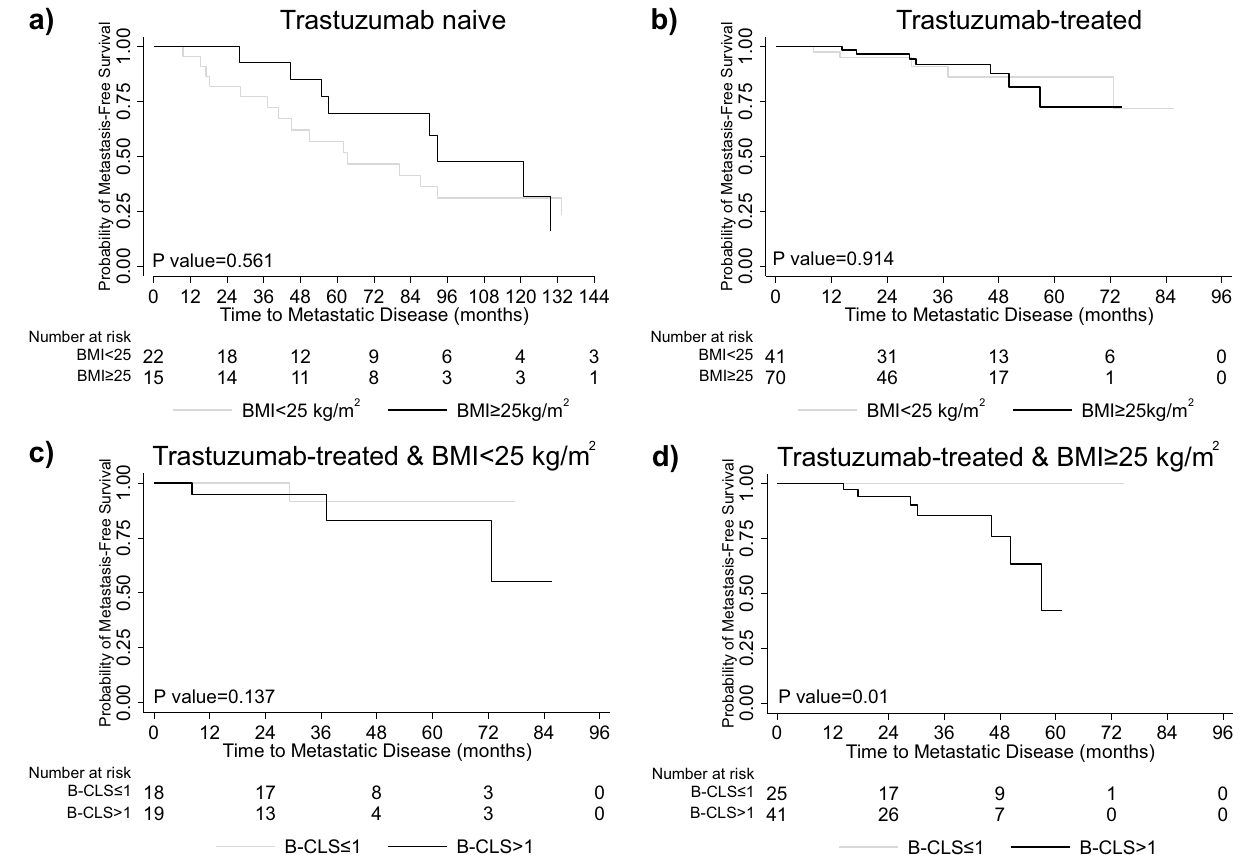
Figure 4. Kaplan–Meier curves showing time to metastatic disease in trastuzumab naïve and trastuzumab- treated patients. Comparison of patients with ( a,b ) BMI < 25 kg/m 2 versus BMI ≥ 25 kg/m 2 ; ( c,d ) Analysis of trastuzumab-treated only patients stratified by BMI comparing B-CLS ≤ 1 versus B-CLS >